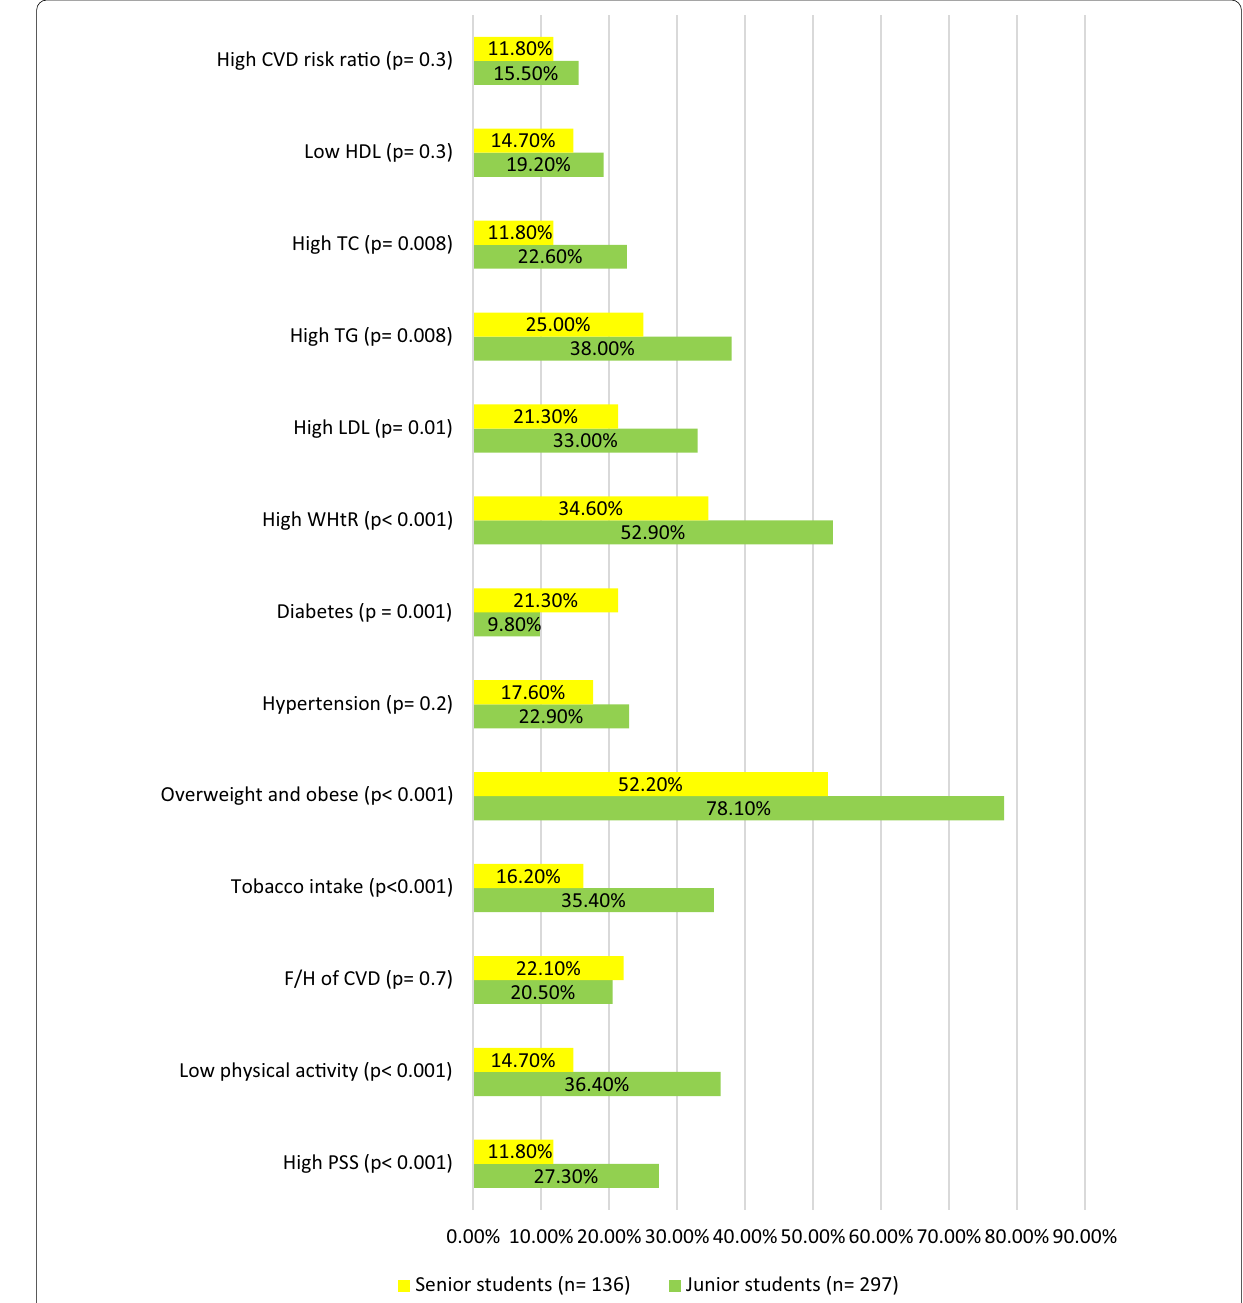
Fig. 2 Cardiovascular risk factor prevalence among junior students and senior